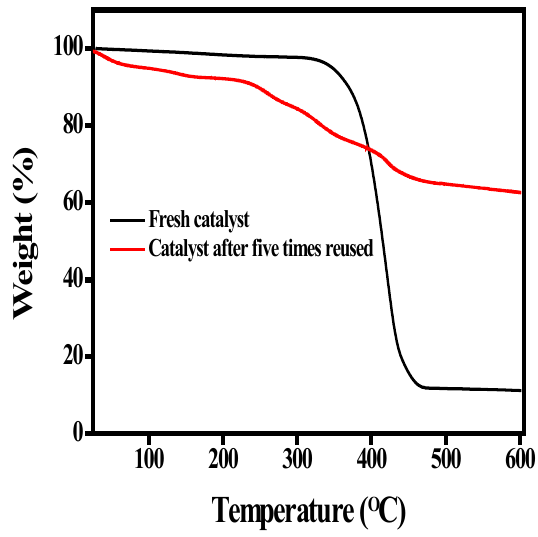
Figure 11: Comparison of the TGA results of the fresh and five times reused EG[Vim]